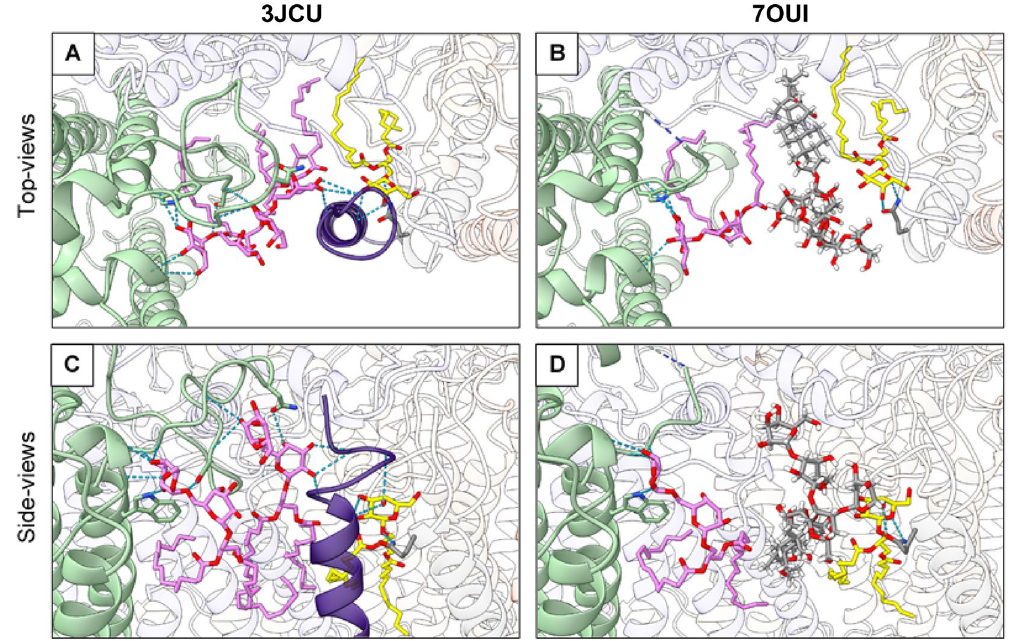
( B ) are top-views, while ( C ) and ( D ) represent views along the membrane plane, centered around the DGD520 lipid (in pink) present in 3JCU, but replaced by a digitonin molecule in 7OUI. Hydrogen bonds are represented by dashed blue lines and the interrupted loop E of CP43 is represented by a dashed-line half-coloured in blue (N-terminus) and light green